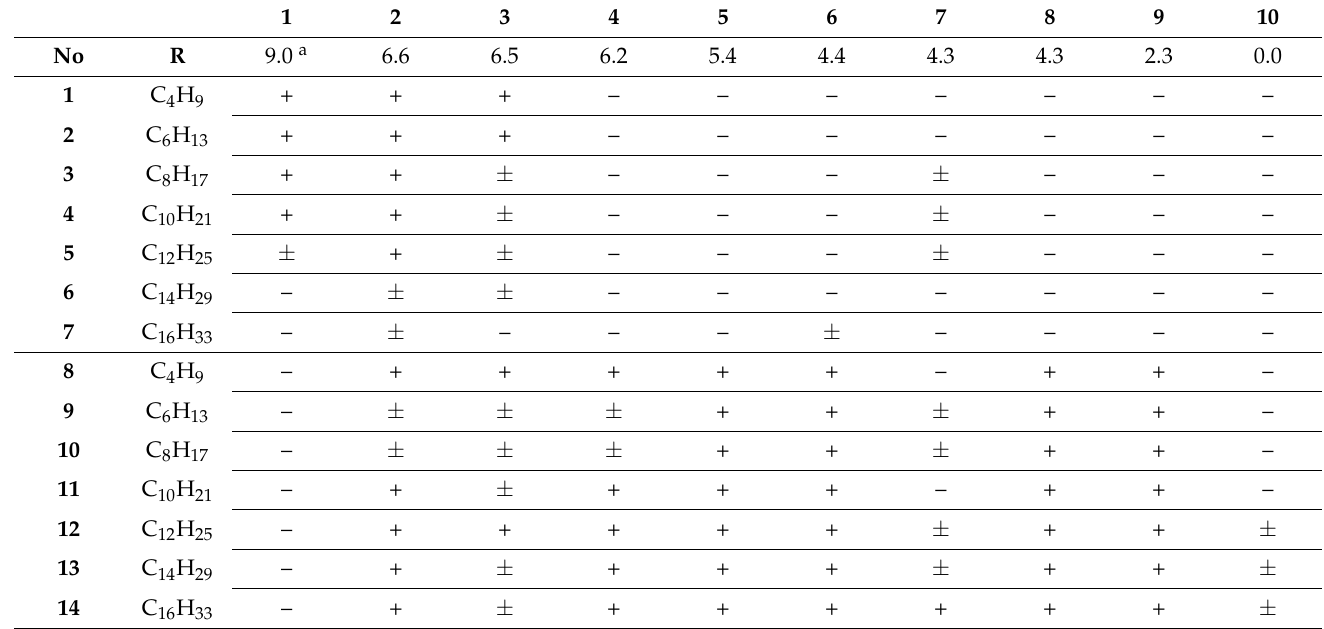
Table 3. Solubility of the prepared products ( 1 – 14 ) at 25 ◦